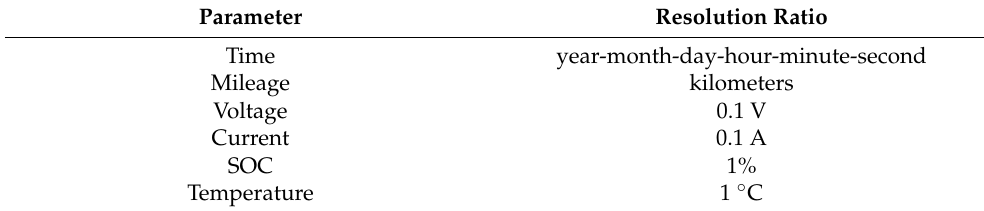
Table 1. Sampling